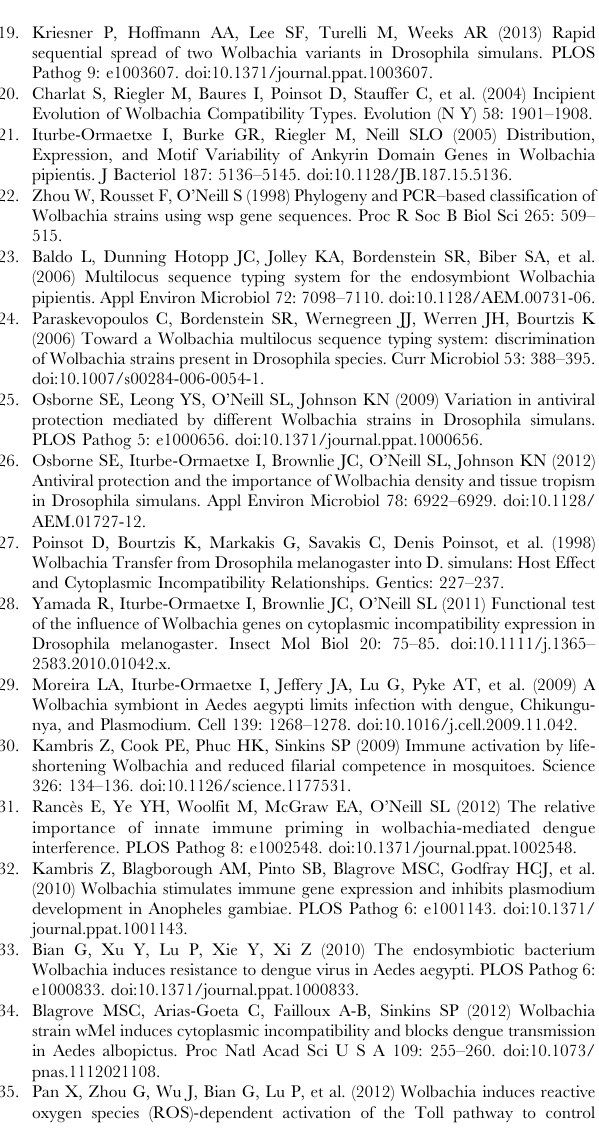
Figure S1 Statistical analysis of survival curves.